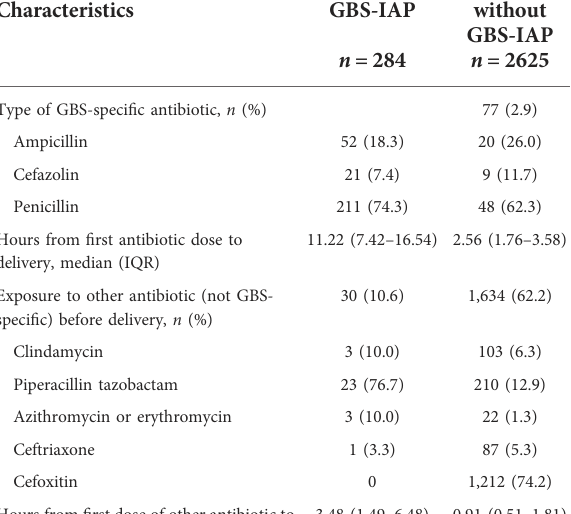
TABLE 2 Characteristics of GBS-IAP between without GBS-IAP group and with GBS-IAP group. Characteristics